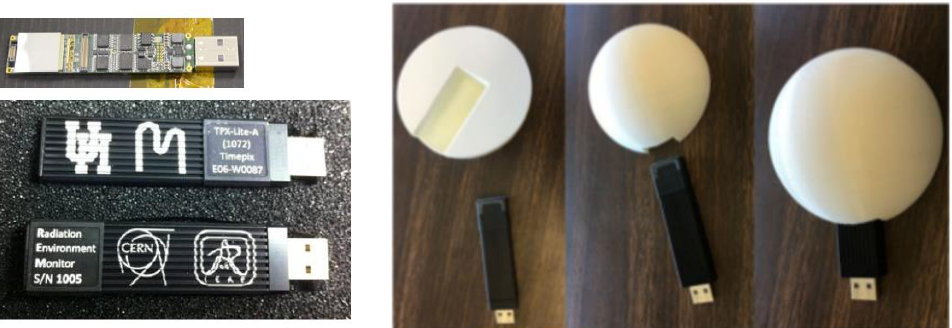
Figure 4. Radiation monitoring sensors and AM parts experimented inside the BEAM module [33]. Credit: NASA .